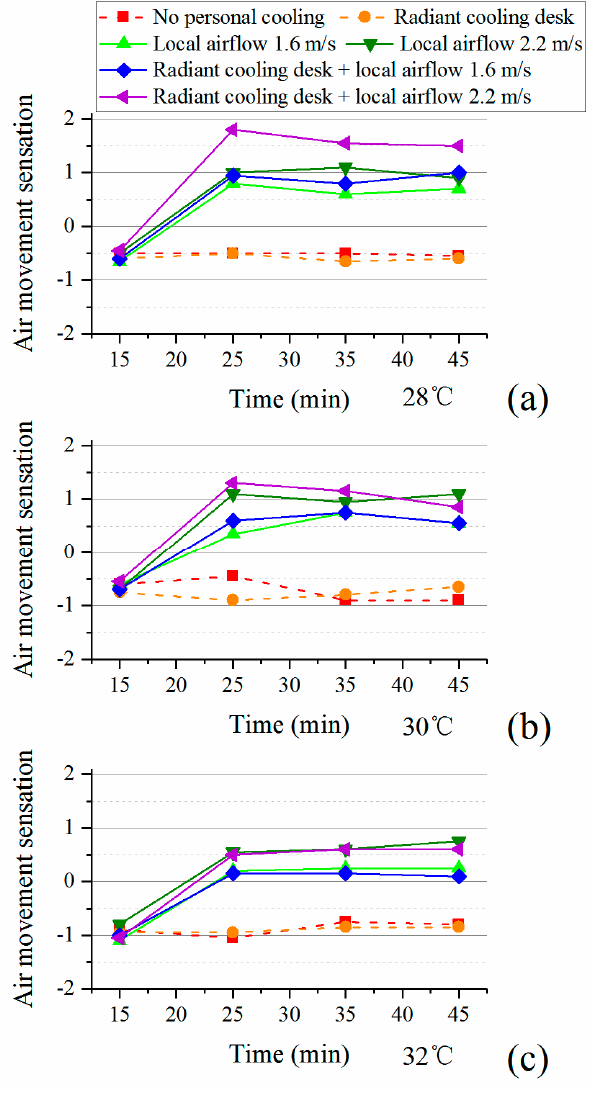
Figure 8. Air movement sensation with personal cooling systems: ( a ) 28 °C; ( b ) 30 °C; ( c ) 32 °C.